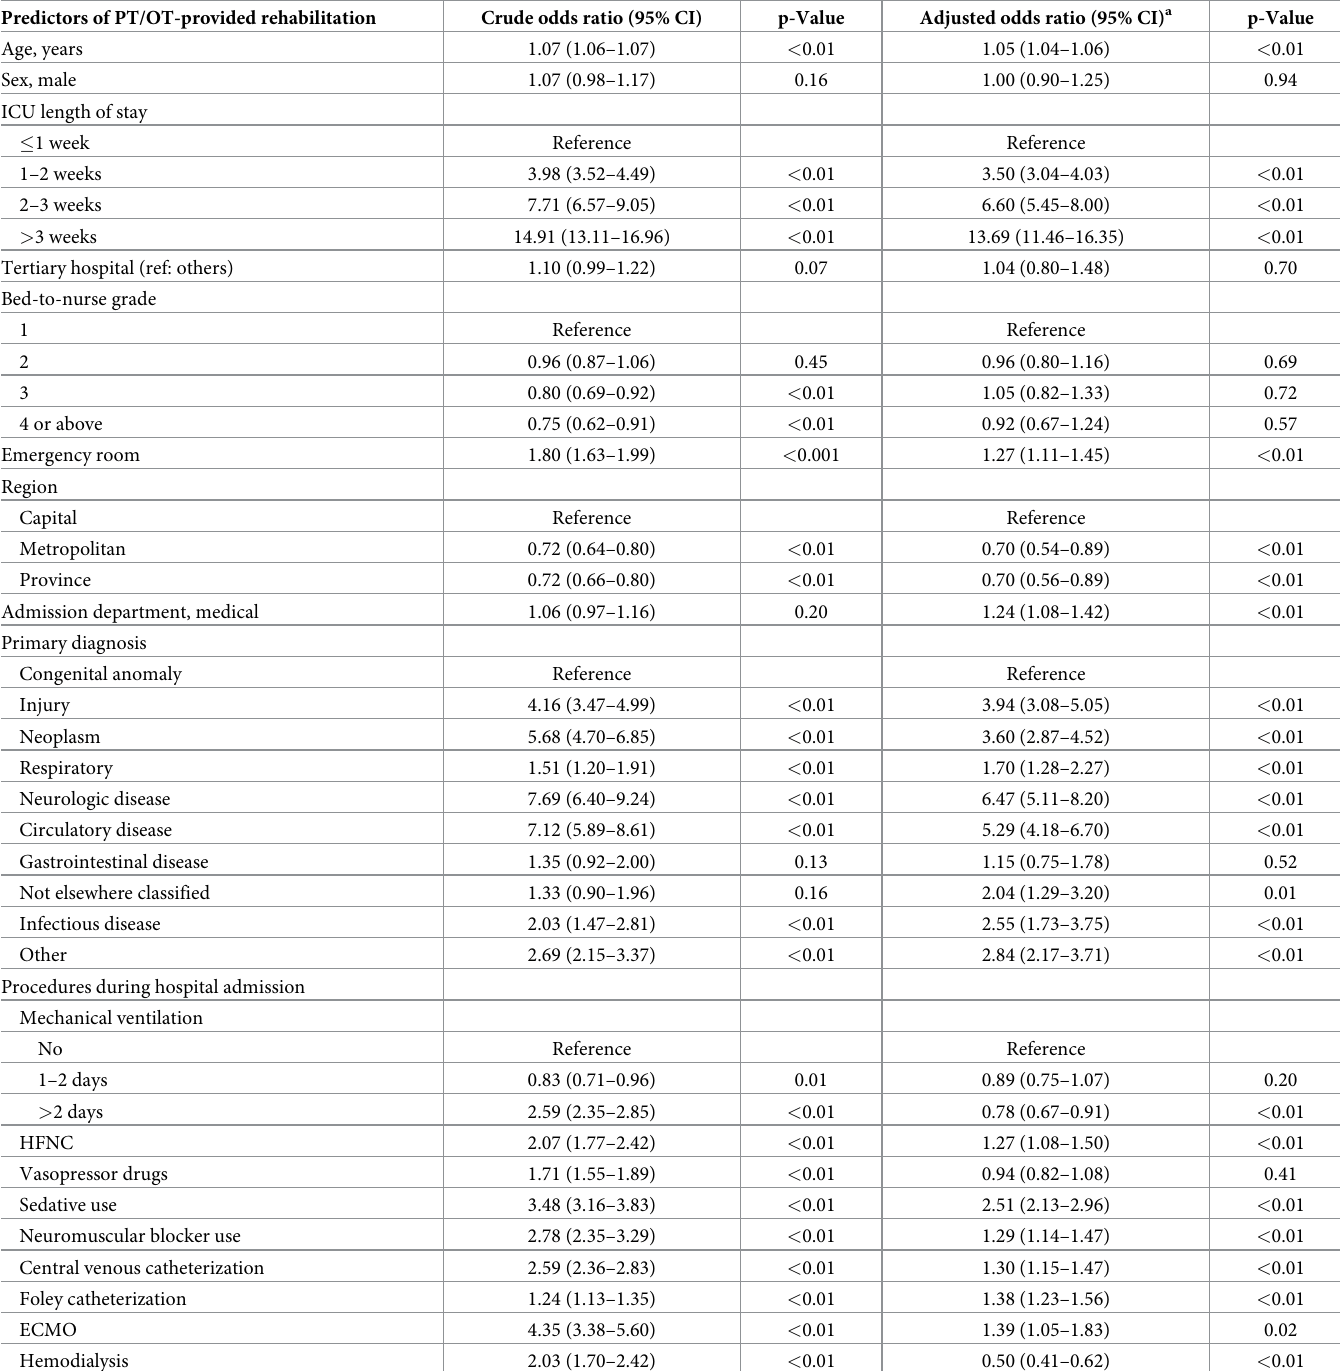
Table 3. Odds ratio (95% CI) for PT/OT-provided rehabilitation of critically ill children in intensive care units in Korea, 2013 to 2019. Predictors of PT/OT-provided